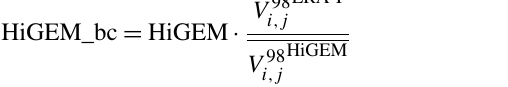
sign and are now positive, and there are also some regions that still have negative anomalies, resulting in an overall neu- tral anomaly compared to